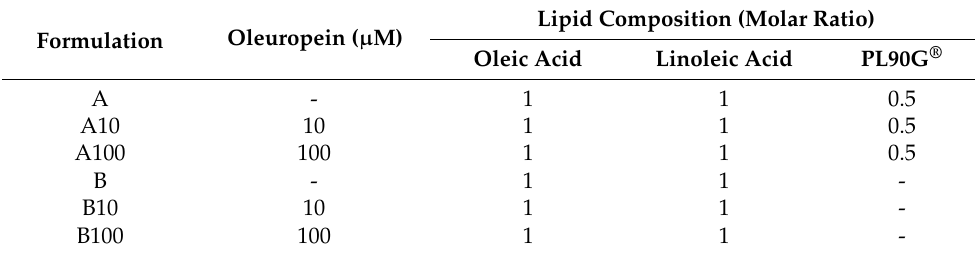
Table 1. Lipid composition of different ufasomes